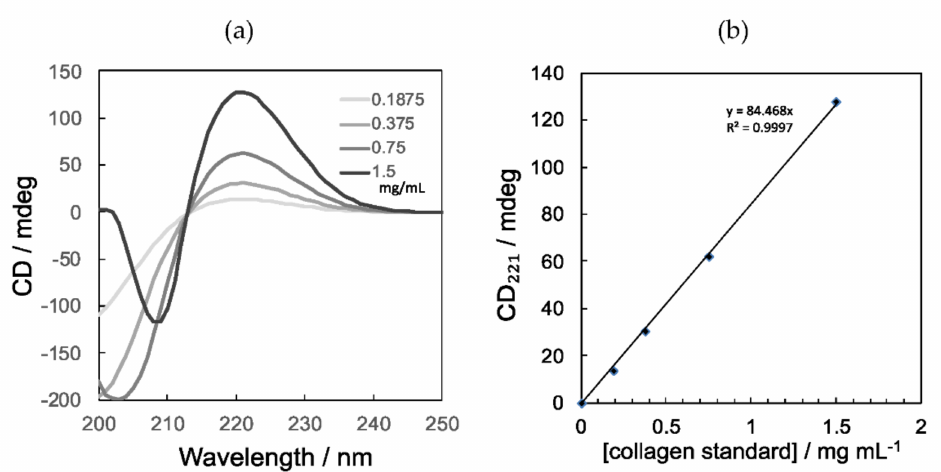
Figure 3. ( a ) Variation in the circular dichroism (CD) spectral pattern as the concentration of com- mercial, standard type I collagen changes; ( b ) Plot of the CD maxima (mdeg) at 221 nm against the collagen concentration of the standard sample, and the resulting equation of the linear approximation.